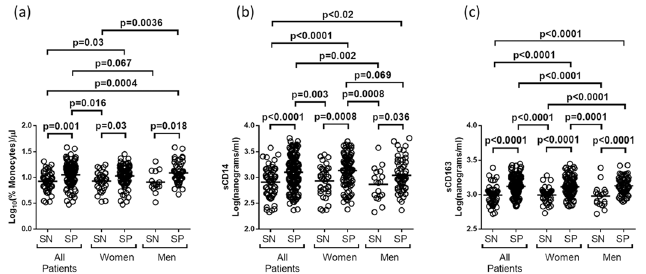
Fig 1. Comparison of monocyte, sCD14 and sCD163 measurements. A comparison was performed of (a) log 10 (%monocyte), (b) sCD14 and (c) sCD163 measurements for all SN and SP subjects and for SN and SP women and men. In nearly all cases, significant differences between SN and SP individuals overall and between the female and male gender groups. Similar levels of these measures were observed for the various SP groups (see the text for additional details).